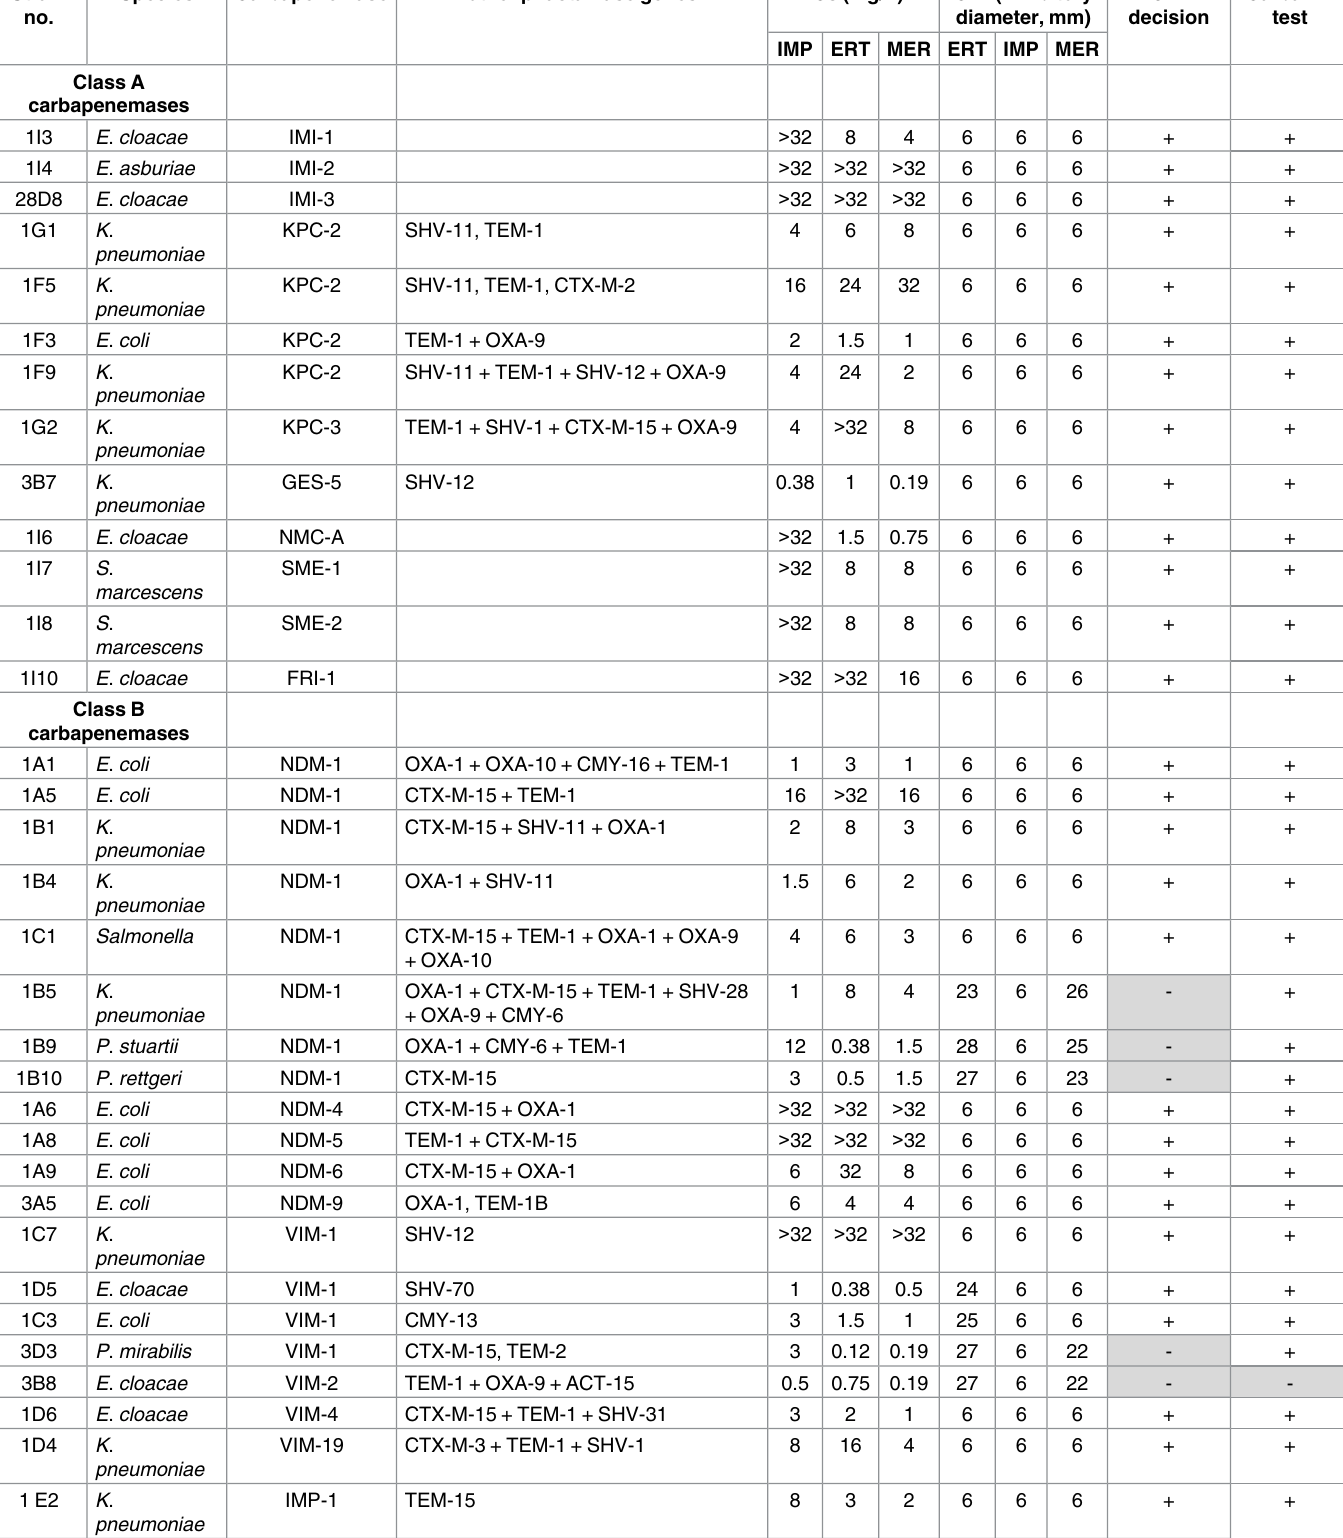
Table 1. Carbapenemase-producing Enterobacteriaceae subjected to the CIM method, compared to the Carba NP test. Strain